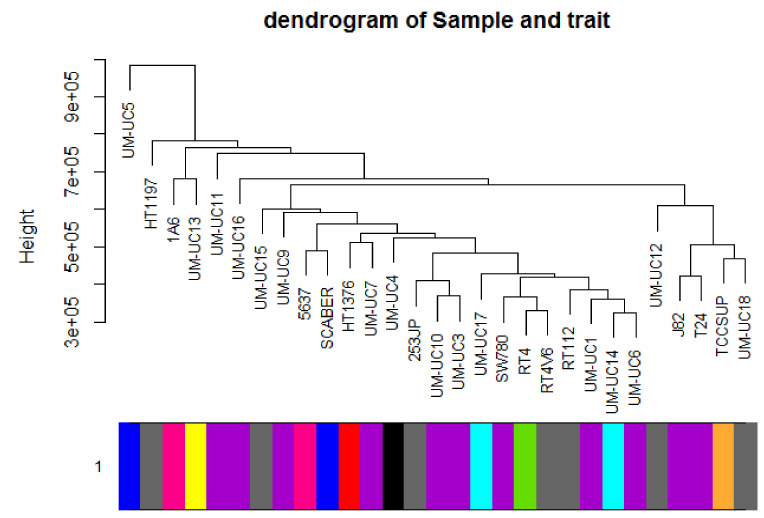
Figure 1. Clustering dendrogram of 29 samples.